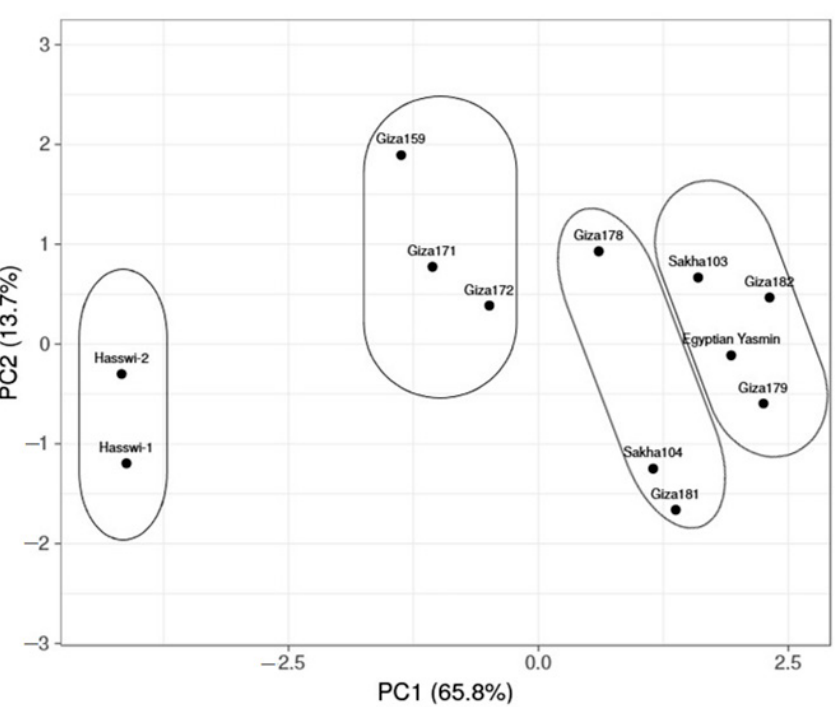
Figure 1. Biplot of principal component analysis (PCA), based on the first two principal components (PC1 and PC2), showing the relationship among the 12 rice genotypes using 11 agro-morphological traits.